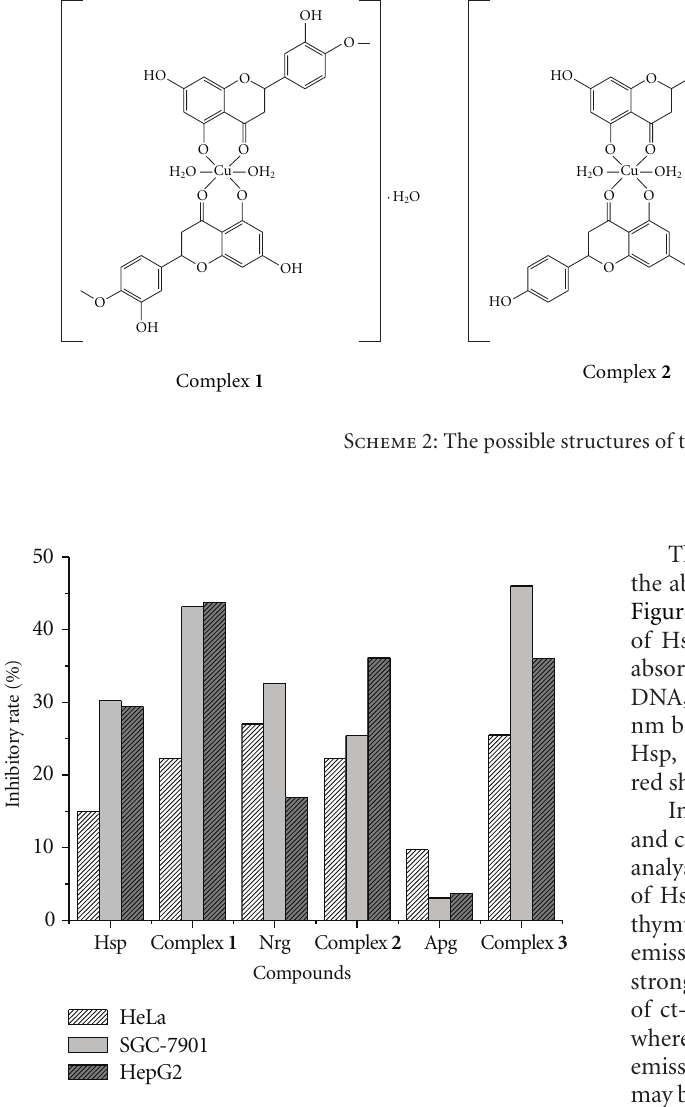
Figure 2: Inhibitory rate of complexes against the tested cell lines.